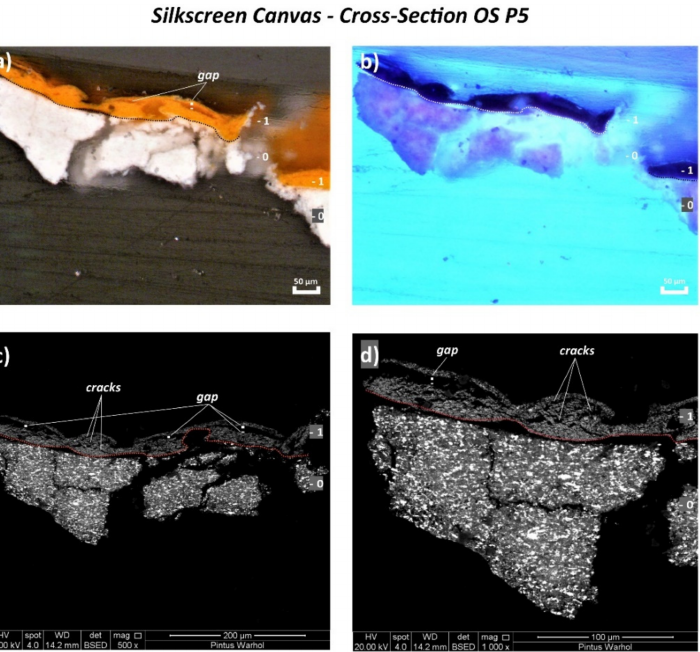
Figure 9. ( a ) Optical microscopy image of the cross-sectioned OS P5 sample under reflected visible light (Vis) showing the main layers and ( b ) under ultraviolet light (UV). ( c ) SEM micrograph of the whole cross-sectioned OS P5 sample and ( d ) detail of the area investigated by bulk area EDX analyses showing the main paint